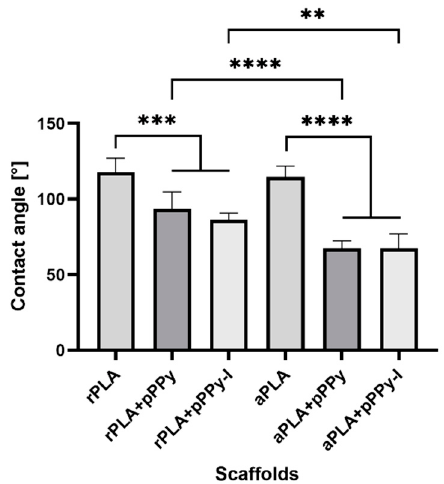
Figure 7. Contact angle of water on the scaffolds. Results are presented as mean ± SD, n = 6, ** p <